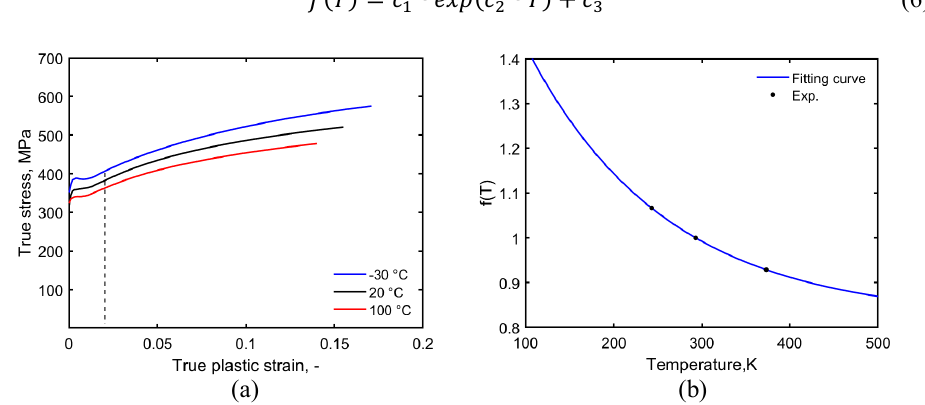
Fig. 5. (a) True stress – true plastic strain curves for various temperatures; (b) Temperature dependence